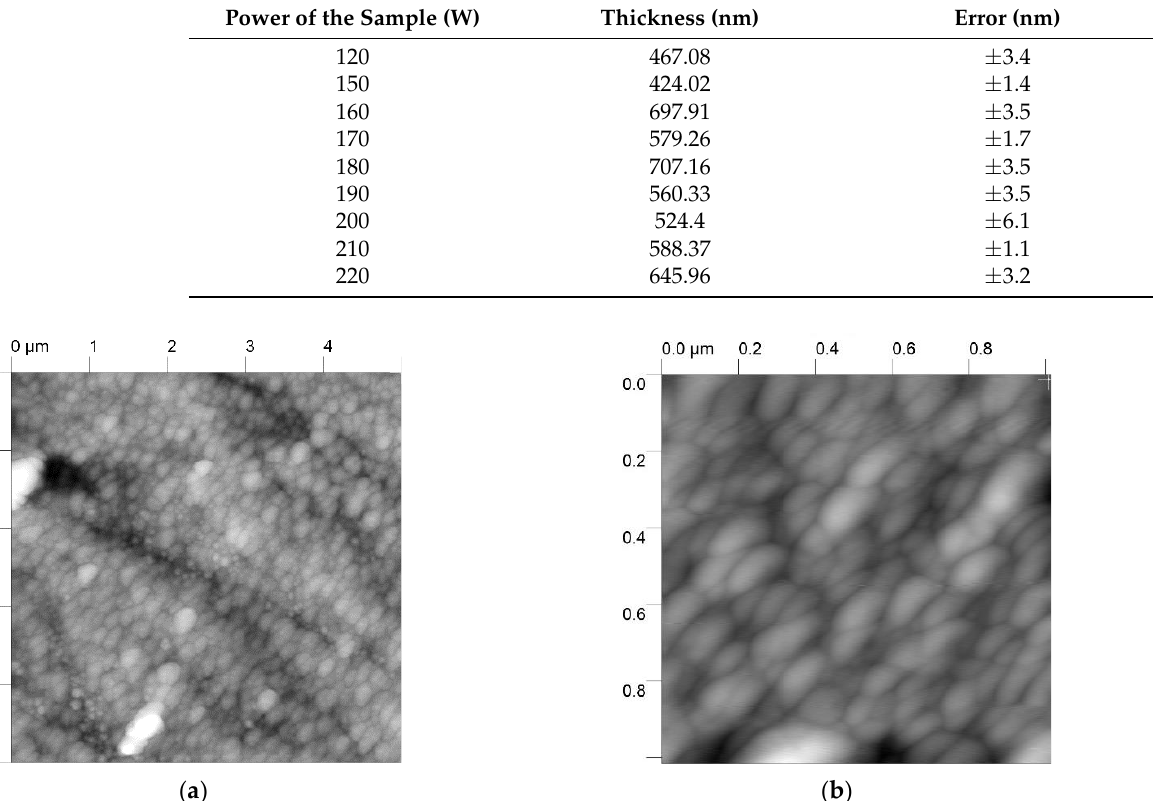
Table 2. Rq Roughness (Rms) of TaN films synthesized using the magnetron sputtering technique.